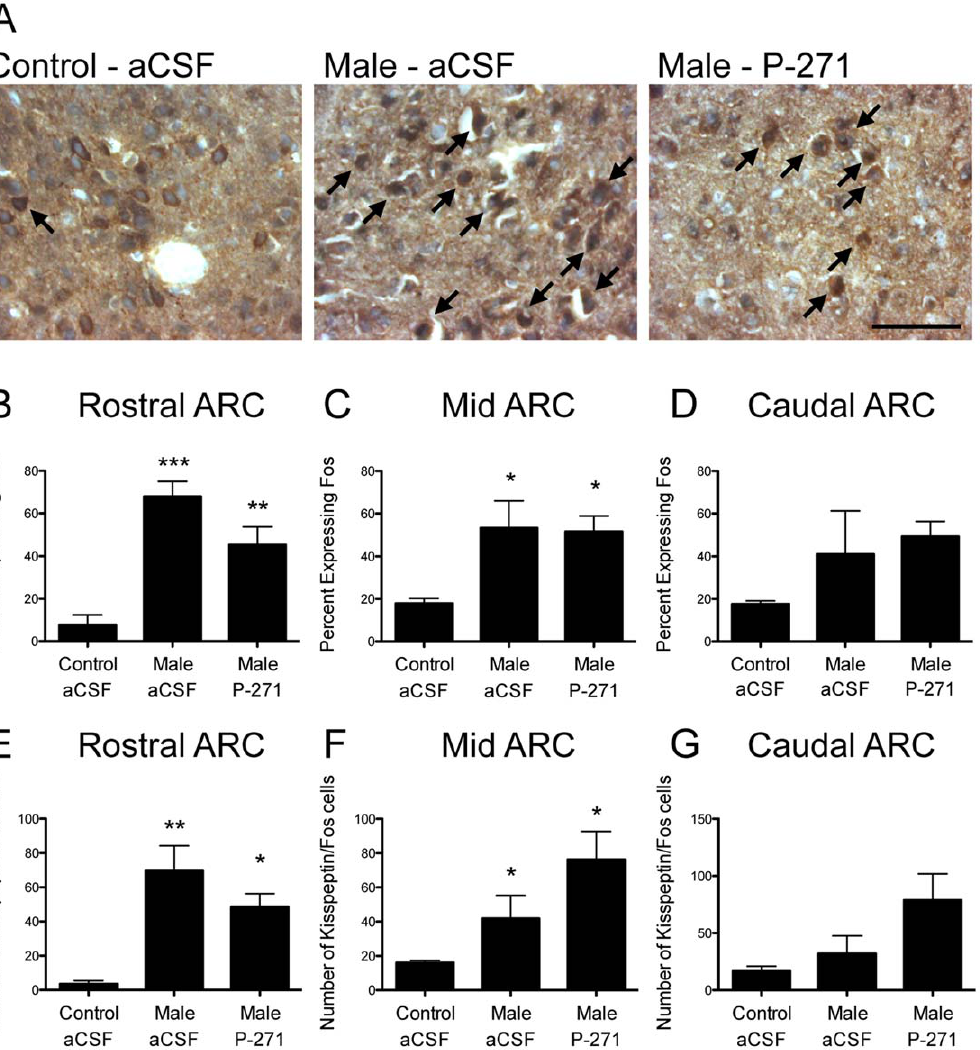
Figure 3. Male exposure in anestrous ewes resulted in Fos induction in ARC kisspeptin neurons. A, Bright-field photomicrographs indicate kisspeptin (brown) and Fos (black) neurons ( arrows ) in the rostral ARC. Scale bar , 50 m m. B–D, In the rostral (B) and mid (C) ARC, the percentage of kisspeptin cells co-expressing Fos was greater in male exposed ewes (note: kisspeptin antagonist treatment did not alter Fos induction in kisspeptin cells). No change was evident in the caudal ARC (D). E-G, The number of kisspeptin/Fos neurons was also higher in male exposed ewes in the rostral (E) and mid (F) ARC. Data are the mean 6 SEM, *P , 0.05, n=4 per group. doi:10.1371/journal.pone.0057972.g003 PLOS ONE |